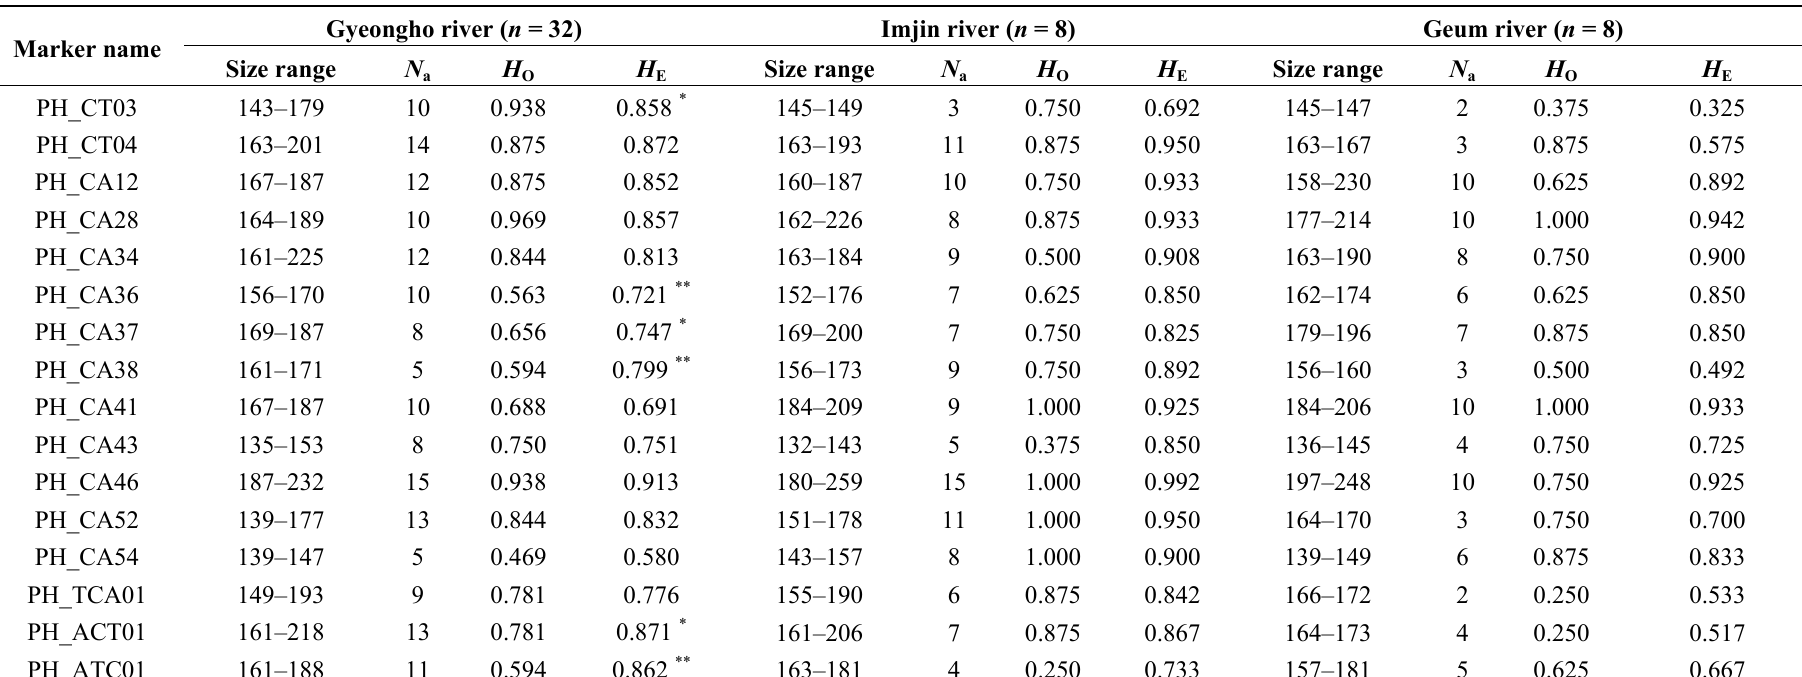
Table 2. Polymorphisms of 16 microsatellite markers developed in Pungtungia herzi